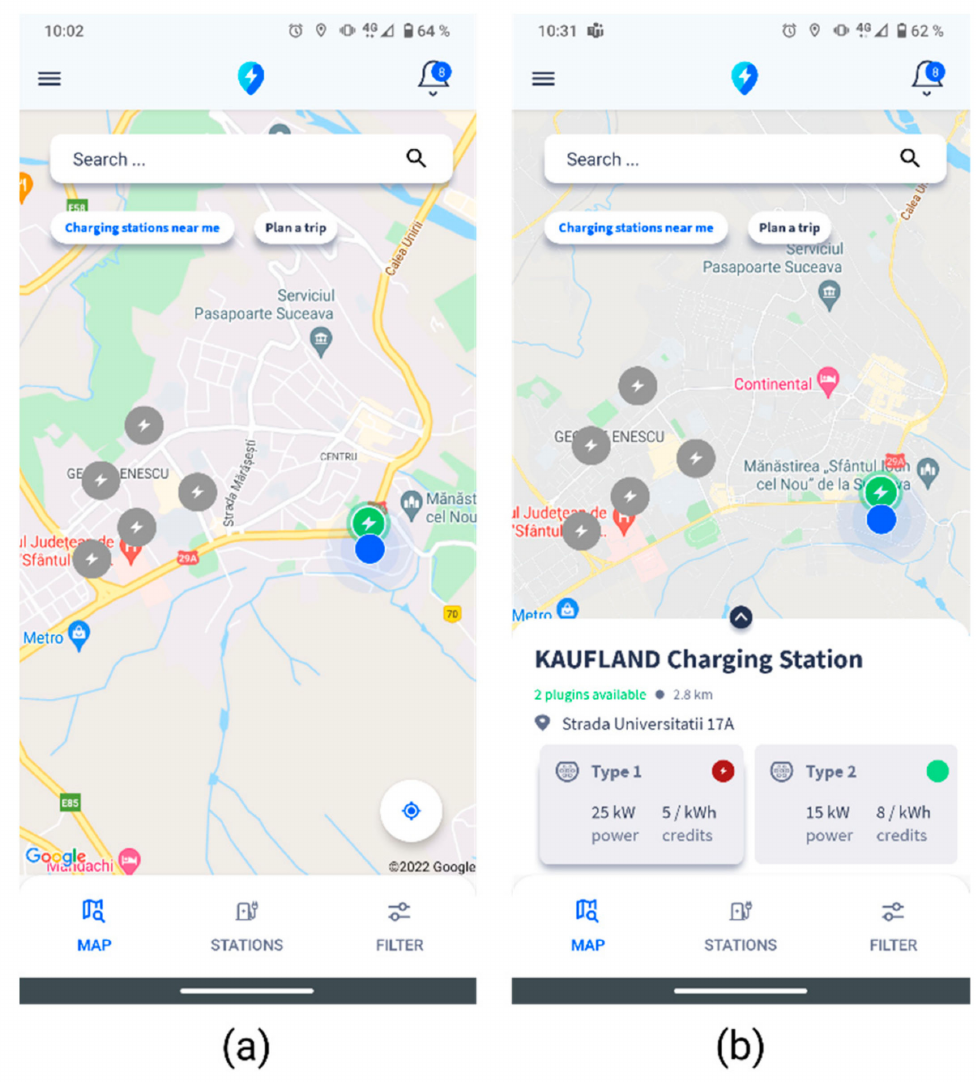
Figure 5. Smart EVC—Charging stations in the vicinity. ( a ) map with charging stations in the vicinity, ( b ) details of a charging station if selected on the